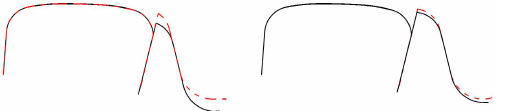
Figure 10. Reduction of different values for the switch rail with some typical cross-sections.